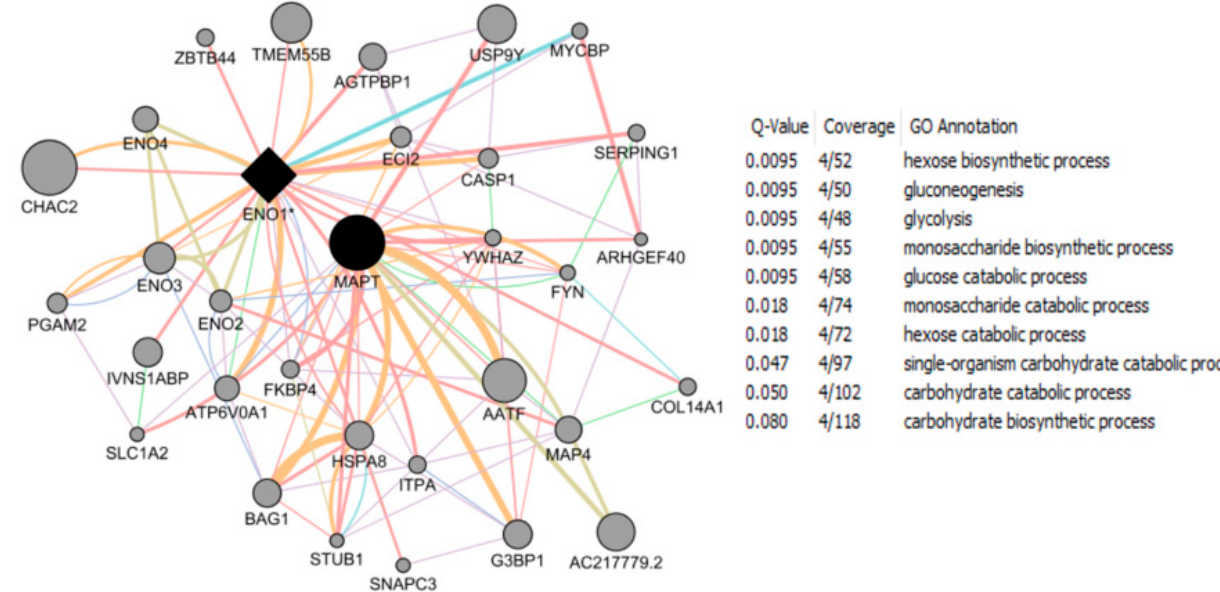
Figure 10. Gene set pathway enrichment analysis of arsenic responsive E2 and NRF1 common target genes associated with Alzheimer’s Disease (AD). The network includes the top 30 arsenic related genes in AD in gray. Arsenic responsive NRF1 genes are in black. Genes denoted by a diamond-shaped node and * are E2 and NRF1 responsive. Right panel show GO annotations of E2 and NRF1 enrichment network genes of arsenic associated with biological process pathways involving multiple E2 and NRF1 genes and Q -value as a probability showing number of genes out of the total genes annotated to each GO term.